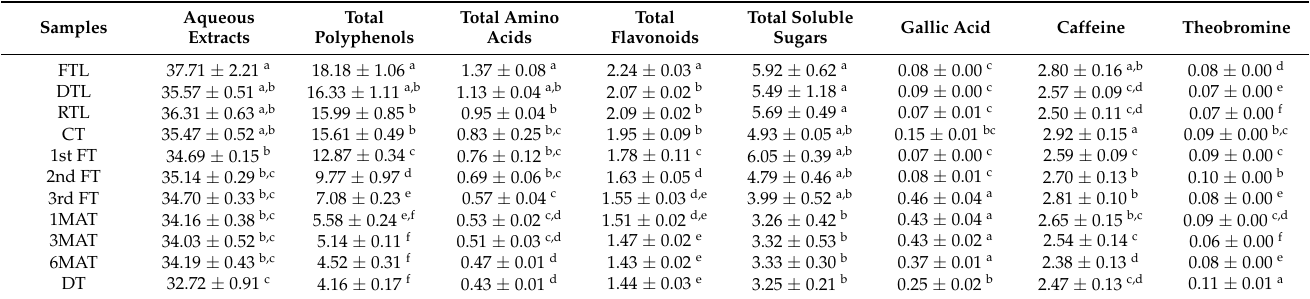
Table 1. The contents of aqueous extracts, total polyphenols, total amino acids, total flavonoids, soluble sugar, gallic acid, caffeine, and theobromine of different processed tea samples (% wt/wt ).